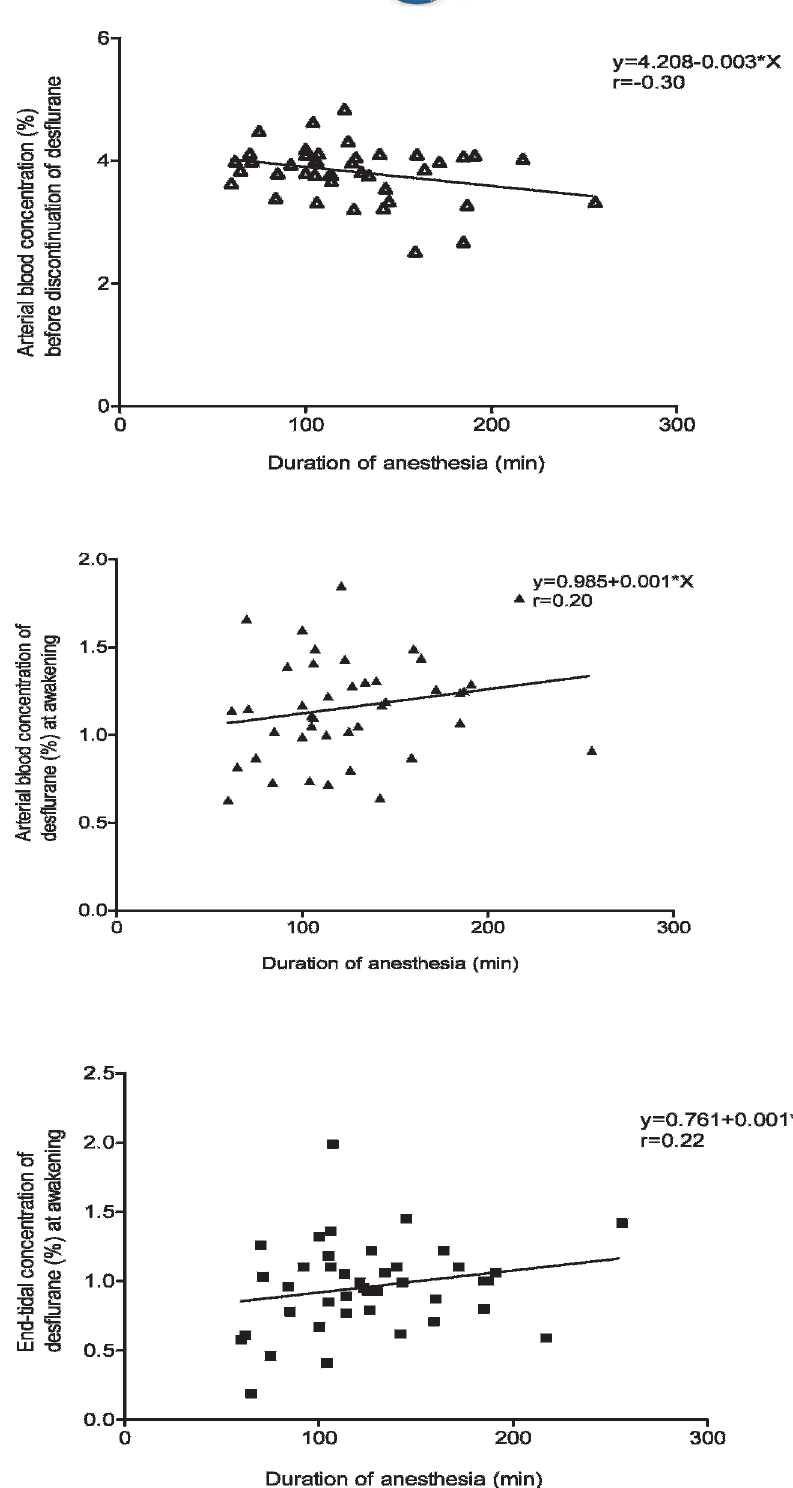
Figure 1 - The correlation between the duration of anesthesia and the arterial concentration of desflurane before discontinuation and at awakening. The arterial concentrations immediately prior to discontinuing 6% desflurane (upper) and at awakening (middle) and the awakening end-tidal concentration (lower) were not correlated with the duration of general anesthesia (60-256